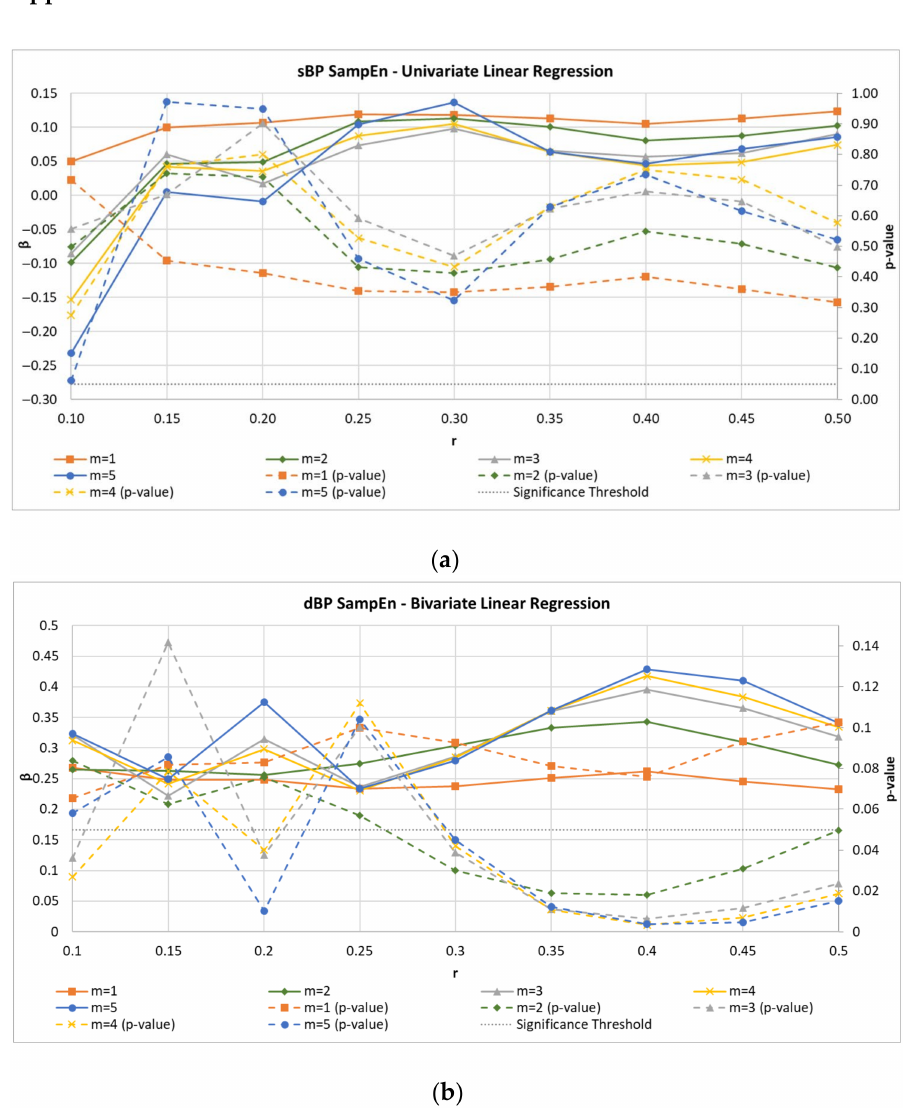
Figure A1. Results from the hyperparameter tuning using bivariate linear regression to investigate associations between the SHARE-FI continuous score and absolute SampEn values for ( a ) systolic blood pressure (sBP) and ( b ) diastolic blood pressure (dBP). The SampEn-associated values varied across m [1, 2, 3, 4, 5] and r [0.1, 0.15, 0.2, 0.25, 0.3, 0.35, 0.4, 0.45, 0.5] ranges. Solid lines show the resulting beta ( β ) coefficients and dashed lines show the associated p